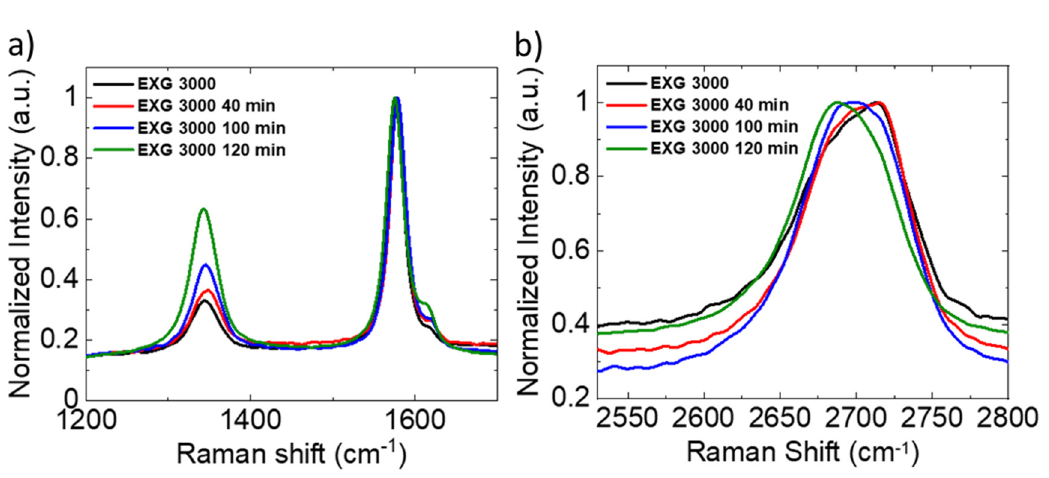
Figure 1. Raman spectroscopy analysis on the ultrasonicated EXG 3000 samples and on pristine EXG 3000. ( a ) Detail of the D and G bands with relative intensity normalized on the G peak. ( b ) Detail of the 2D band. Table 2. Relevant intensity ratios between Raman peaks in Figure